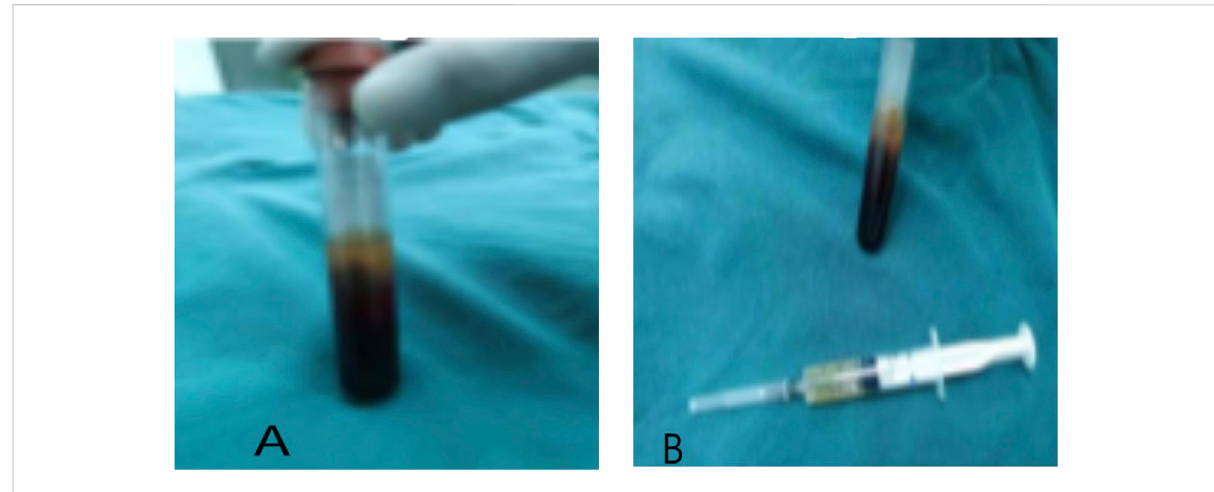
FIGURE 1 The preparation of injectable platelet-rich fi brin by the twice-centrifugation method. (A) : The status of blood samples after the fi rst centrifugation. (B) : The status of blood samples after the second centrifugation, and the injectable platelet-rich fi brin has been transferred to a syringe for